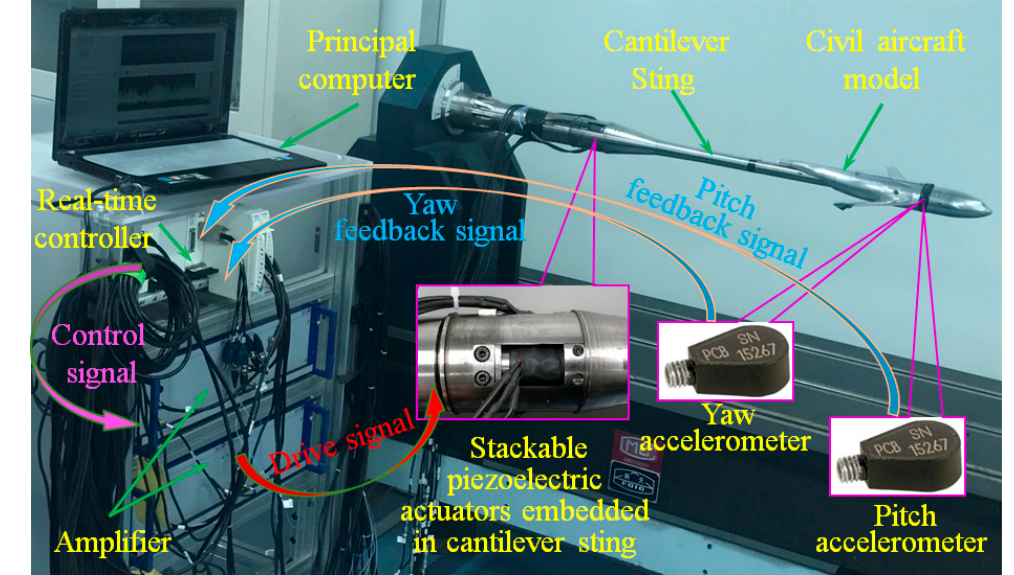
Figure 4. Diagram of multidimensional vibration suppression system. Table 1. Parameters of stackable piezoelectric actuator.